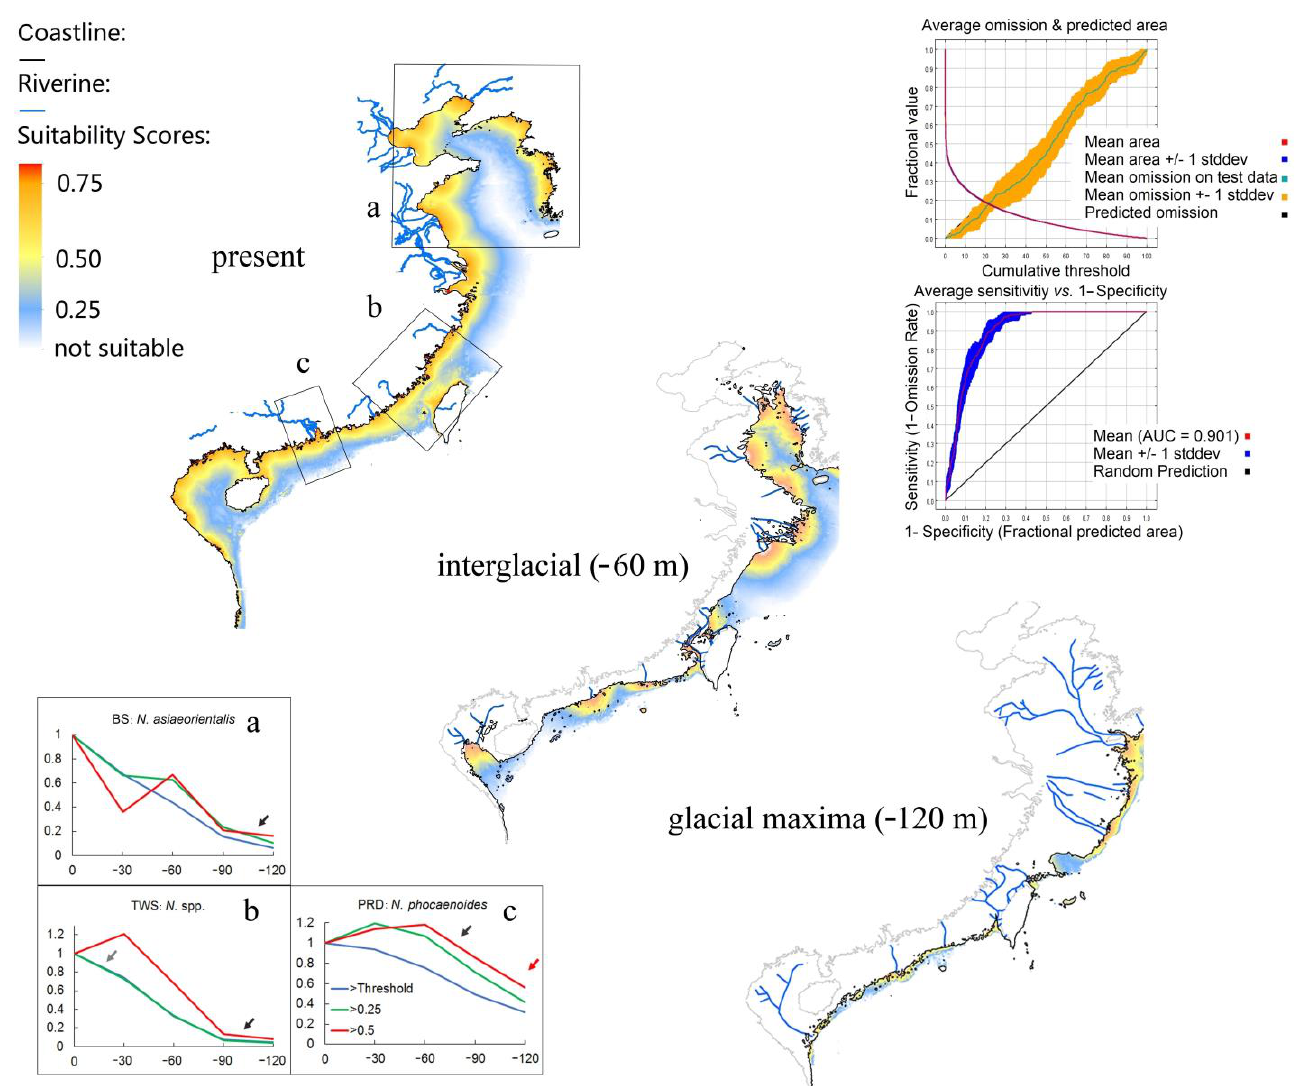
Figure 5. Predicted distribution of the finless porpoise in coastal waters off present-day China under different sea level scenarios (present sea level, − 60 m below the present sea level, and the last glacial maximum/LGM). The paleo-rivers were reconstructed according to [40,72]. The relative size of suitable niche (above the threshold value, >0.25 and >0.5) corresponding to different sea levels in ( a ) the Bohai/Yellow Sea, ( b ) Taiwan Strait, and ( c ) the Pearl River Delta region is shown in the panels on the bottom left, with the arrows indicating the onset of the latest population expansion consistent with Figure 4. The onset of the most recent expansion for the PRDw population estimated by MIGRAINE is also shown with red arrow for comparison. At the top right, we show the averaged omission rate and predicted area as a function of the cumulative threshold, and the receiver operating characteristic (ROC) curve averaged over multiple replicates for the niche modeling.